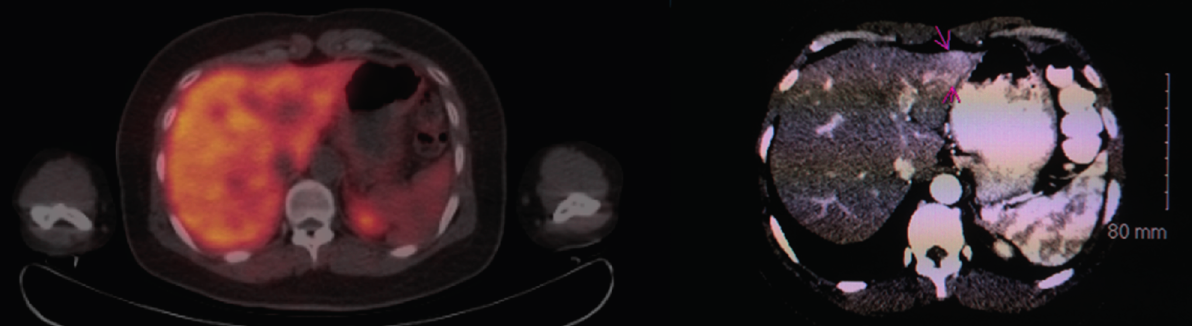
Figure 7. Primary HCC demonstrating iso-intense FCh uptake in non-cirrhotic patient. PET/CT image ( left ) shows no focal area of increased FCh uptake in the liver. However, a diagnostic CT scan with intravenous contrast ( right ) revealed a mass showing arterial enhancement and delayed washout in the left hepatic lobe lateral segment ( purple arrows